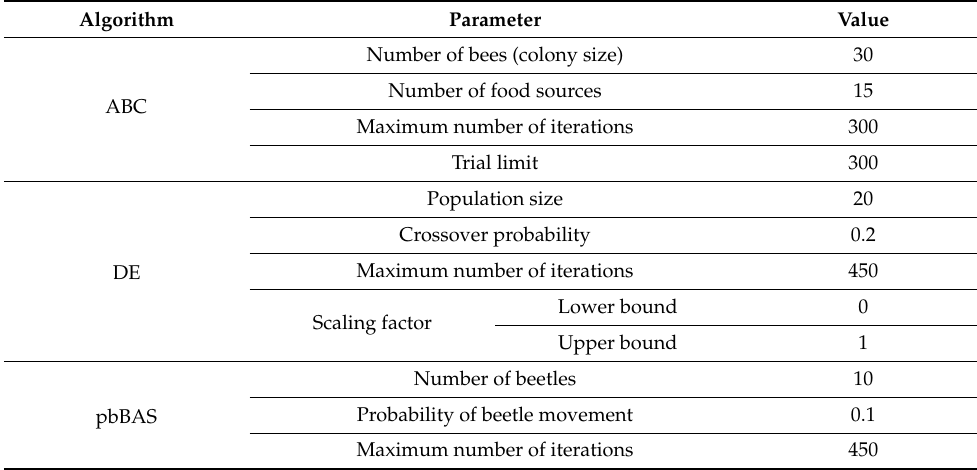
Table 13. Adopted internal parameter values for each metaheuristic algorithm in the V-type folded plate roof building.